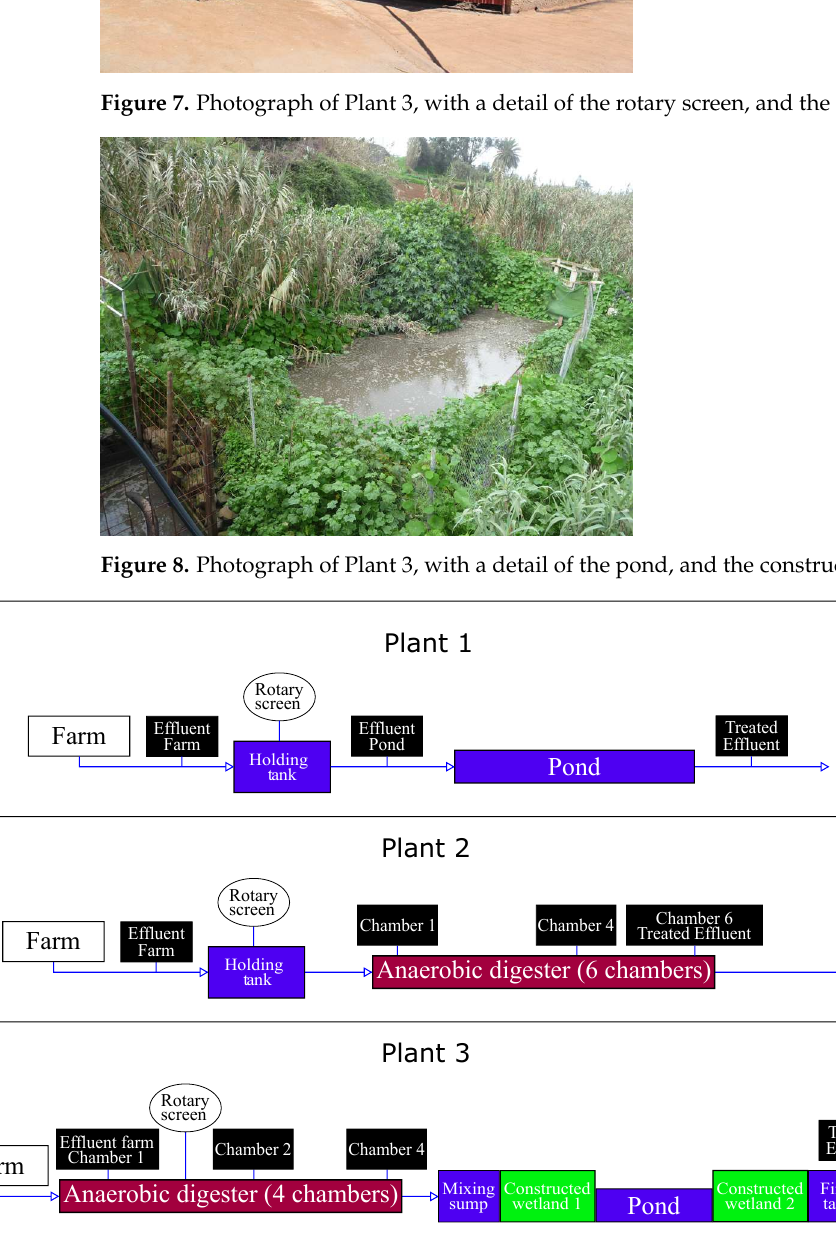
Figure 9. Schematics of the plants and Sampling